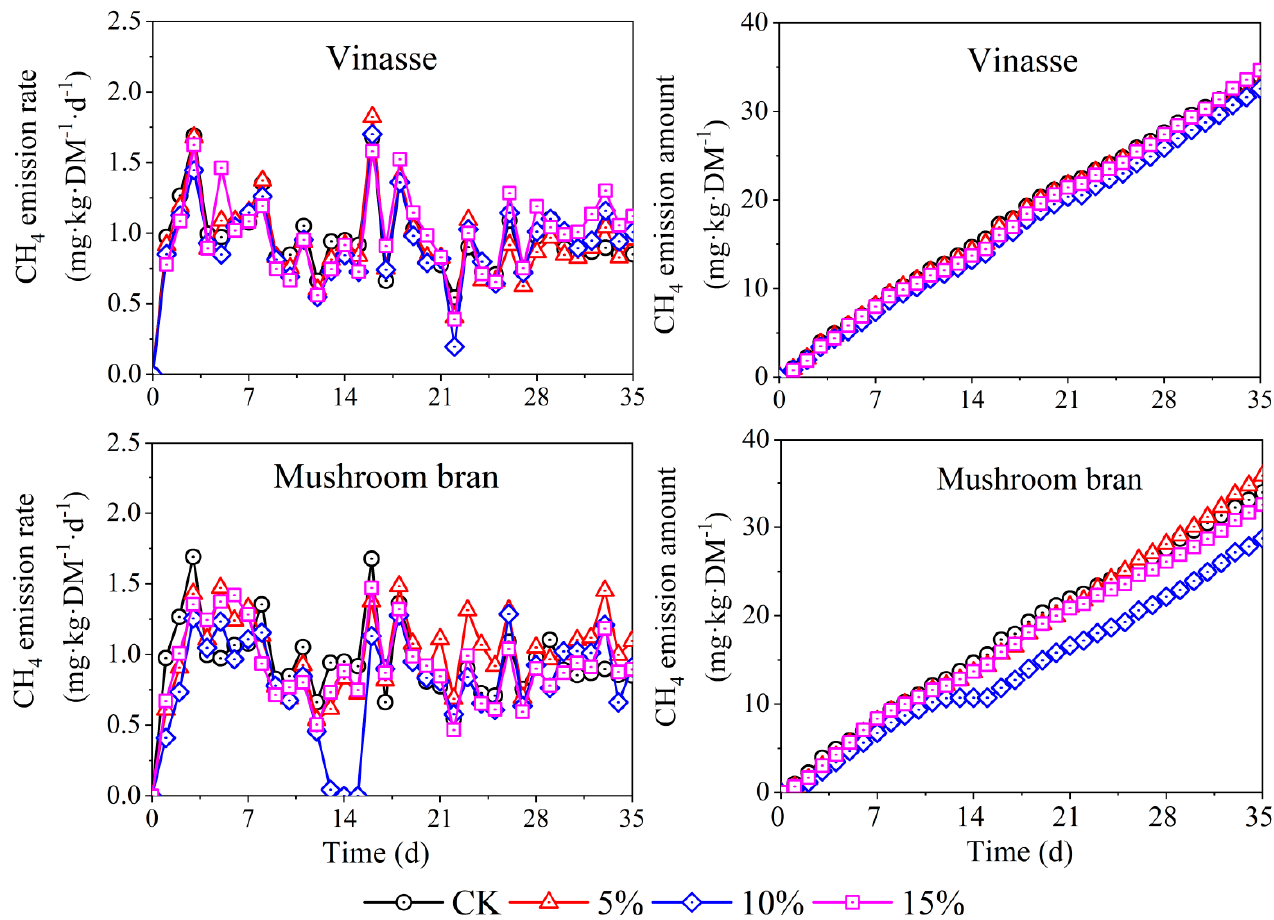
Figure 4. The CH 4 emission of diverse treatments during